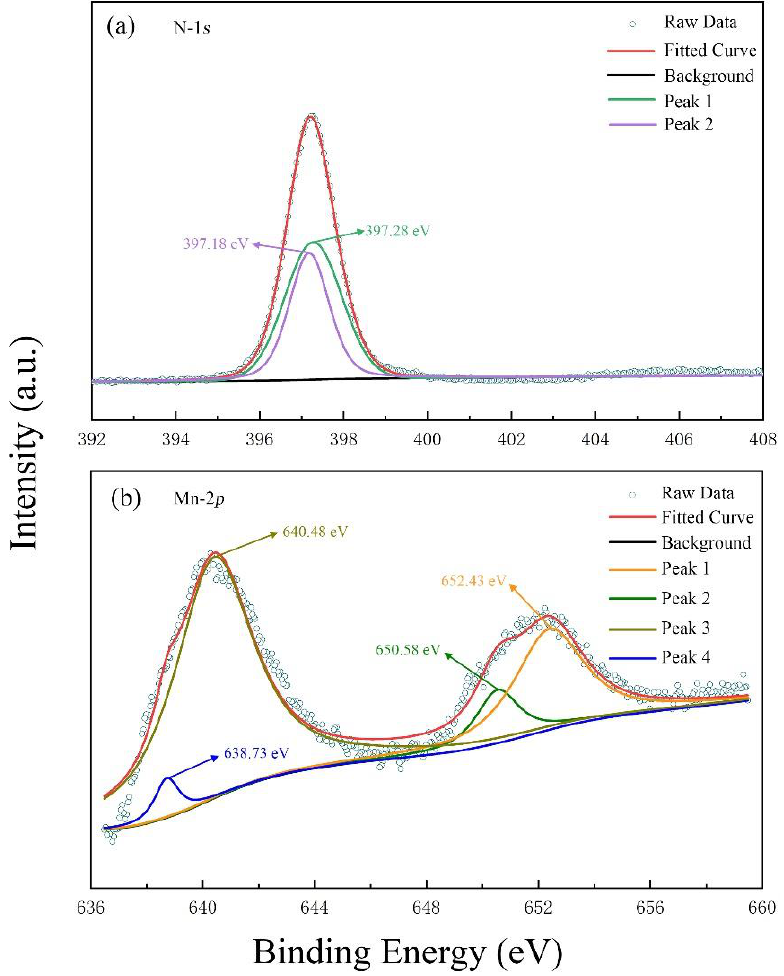
Figure 3. XPS spectra of the Mn 3 N 2 sample. ( a ) N 1 s spectrum with a binding energy of 392.0–408.0 eV; ( b ) Mn 2 p spectrum with a binding energy of 636.48–659.48 eV.